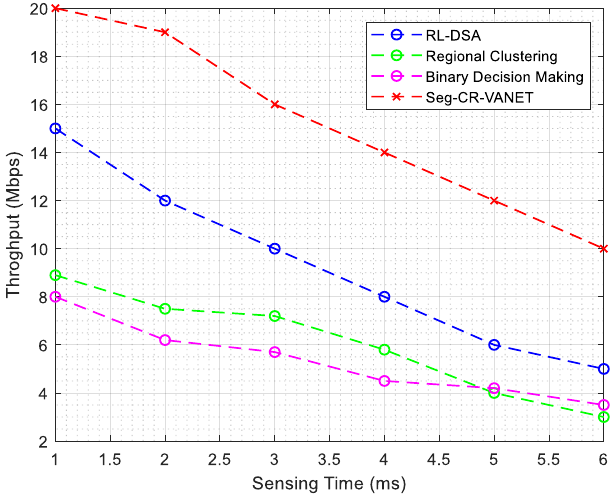
Figure 10. Comparison of throughput and sensing time.